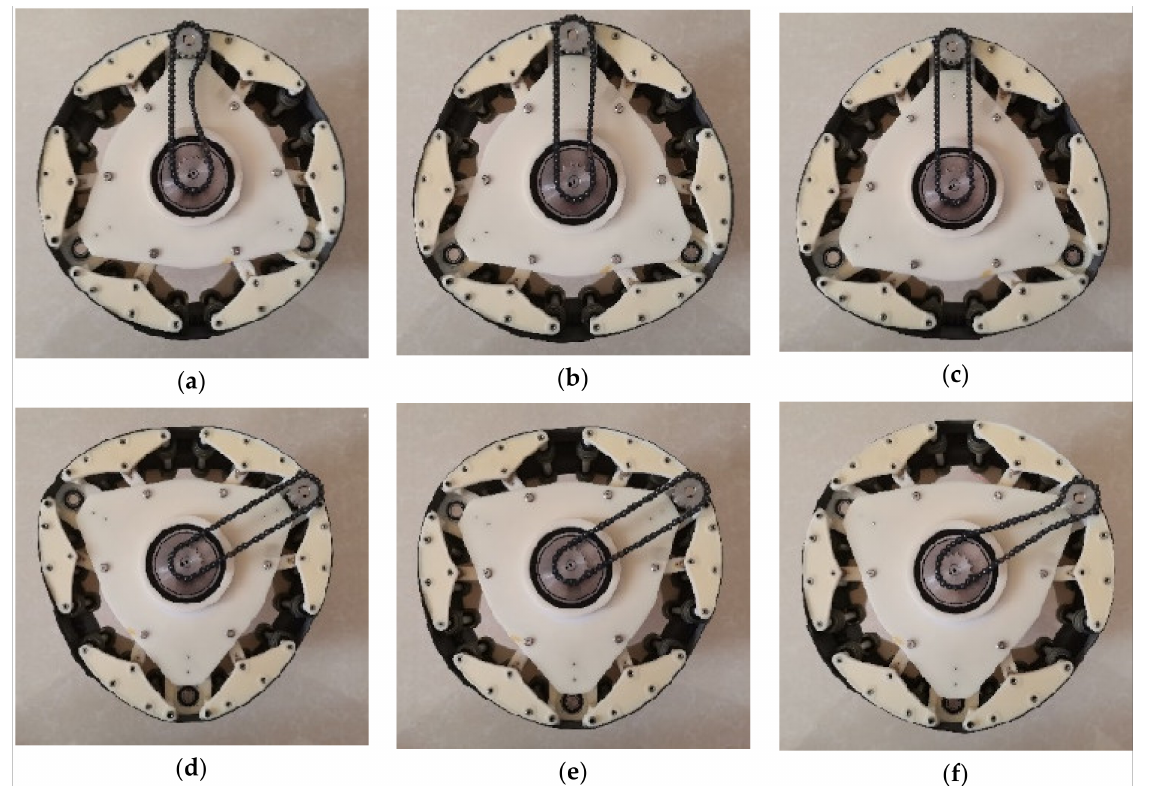
Figure 2. The process of switching to the walking mode of the reconfigurable wheel-crawler integrated mechanism. ( a ) The circular wheel mode; ( b ) the swing arm is recovered, and the traveling mechanism is switched from the circular wheel mode to the triangular crawler mode; ( c ) the triangular crawler mode; ( d ) the triangular crawler mode with the bracket is below; ( e ) the process of changing from the triangular crawler mode to the circular wheel mode, with the bracket is retracting, the swing arm is expanding; ( f ) the circular wheel mode after the mode